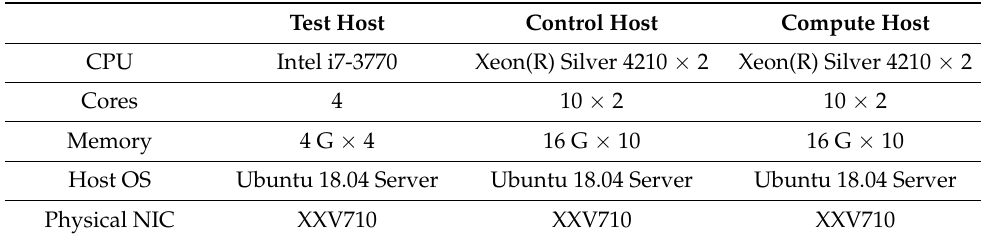
Table 2. Host configurations of the testbed.